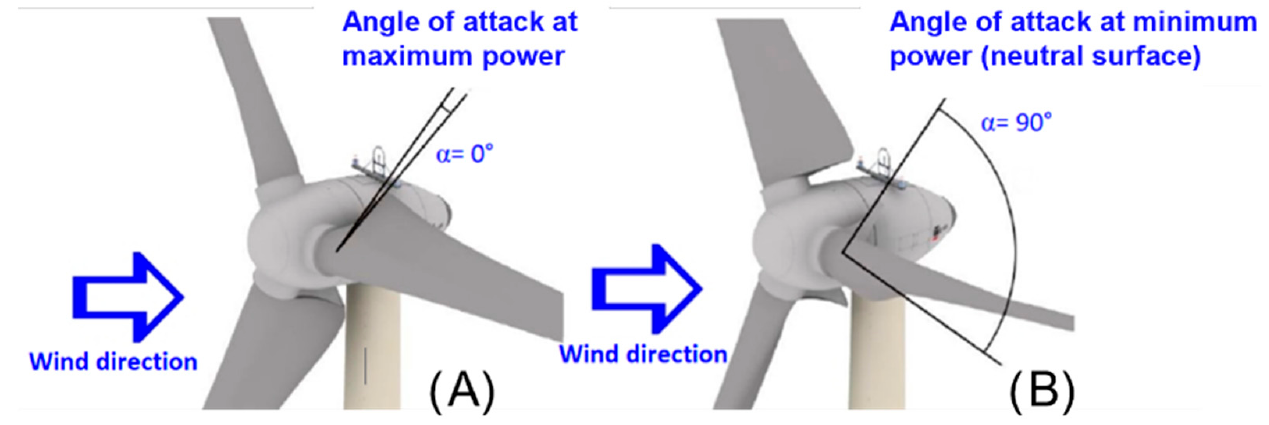
Figure 2. Angle of attack at maximum power ( A ), angle of attack at zero power ( B ) [13].